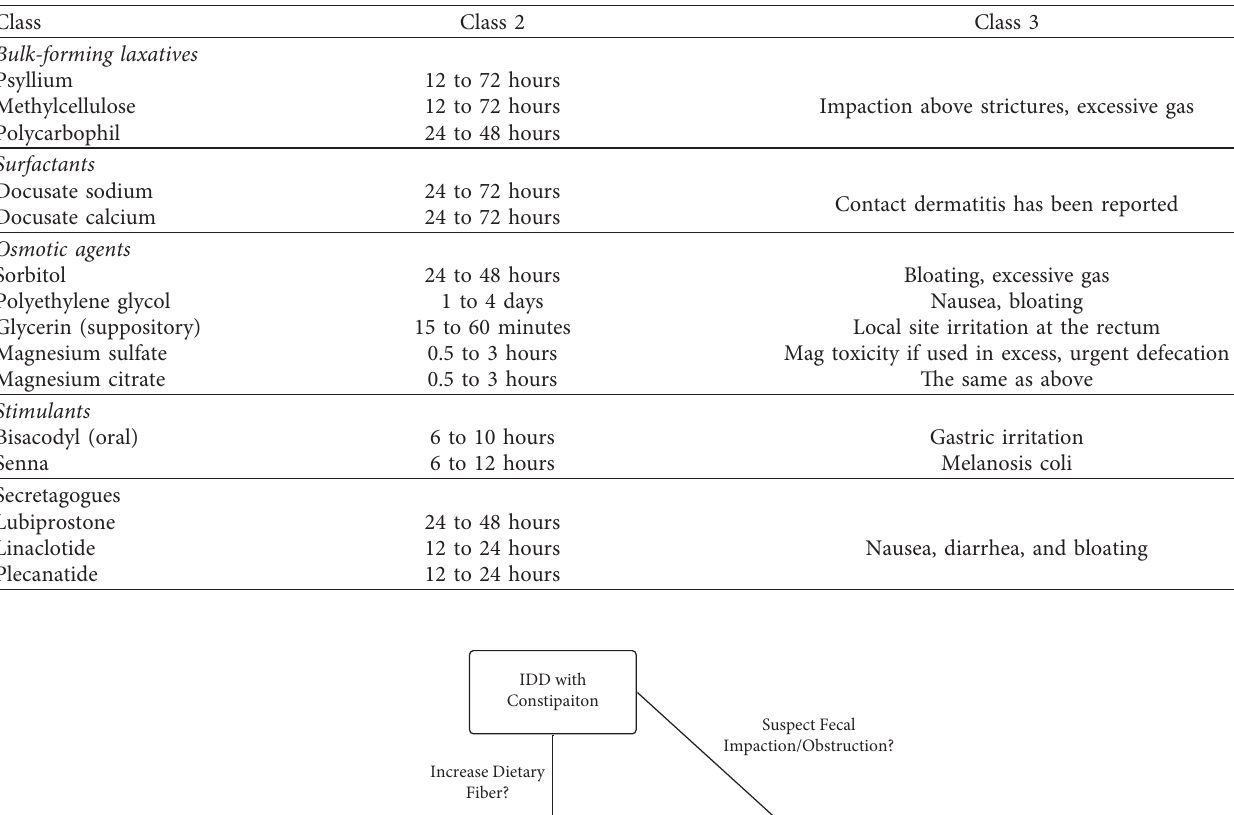
Table 1: Laxative choices.